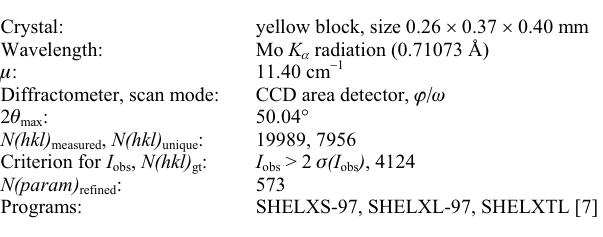
Table 1. Data collection and